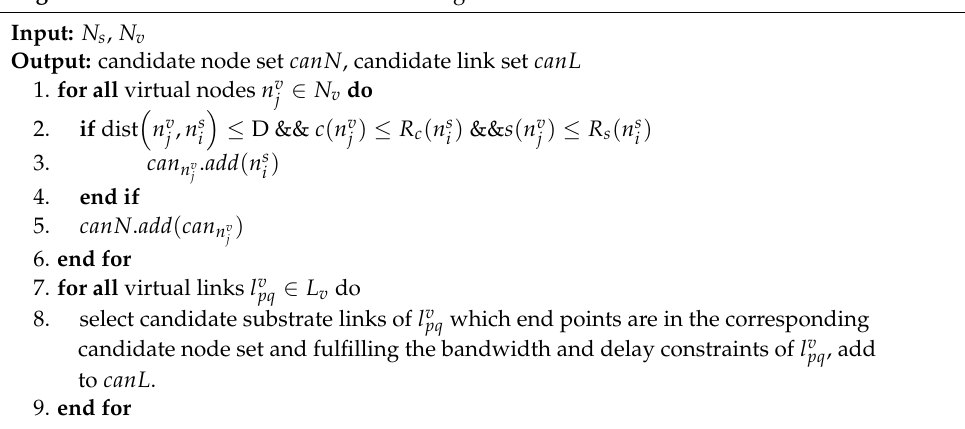
Algorithm 4 Candidate Sets Construction